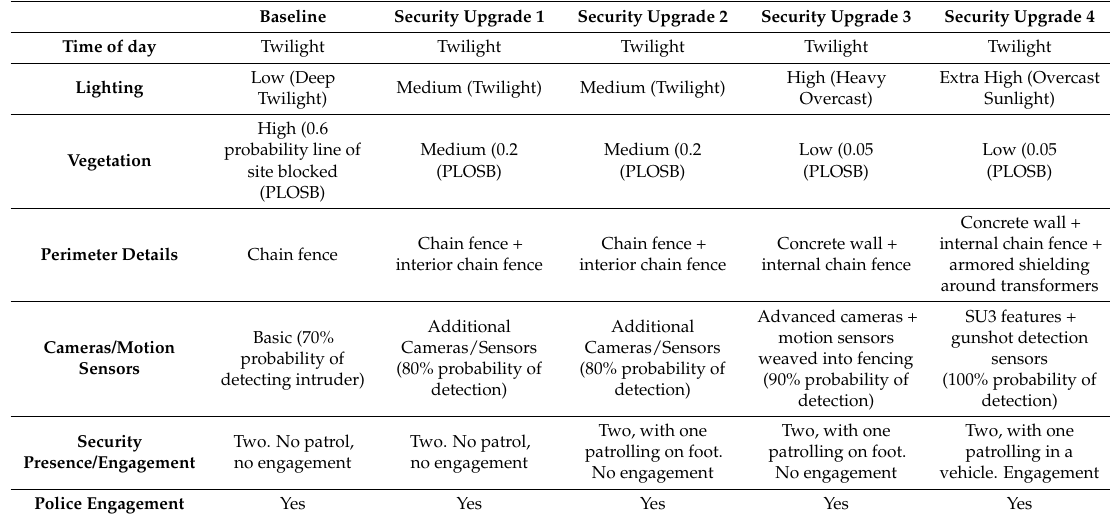
Table 1. Security Upgrade Scenarios (laboratory-specific reference number